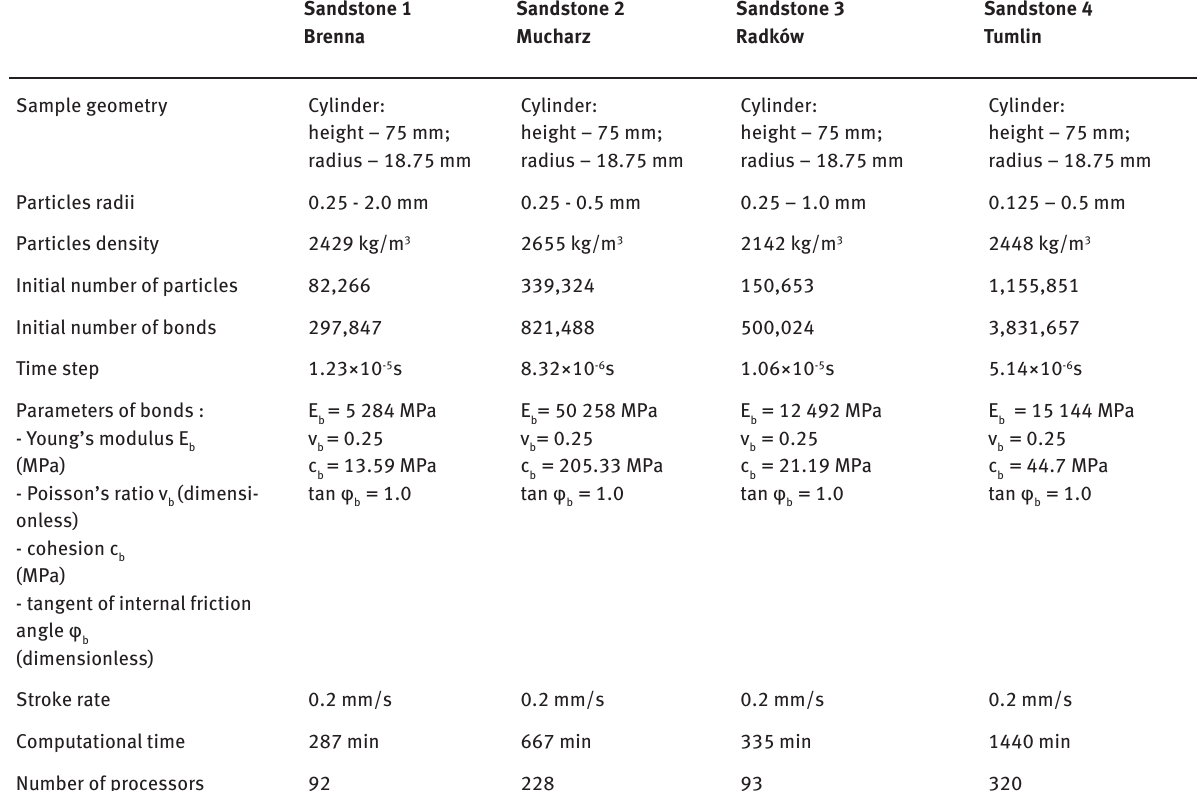
Table 2: Detailed parameters of numerical models of